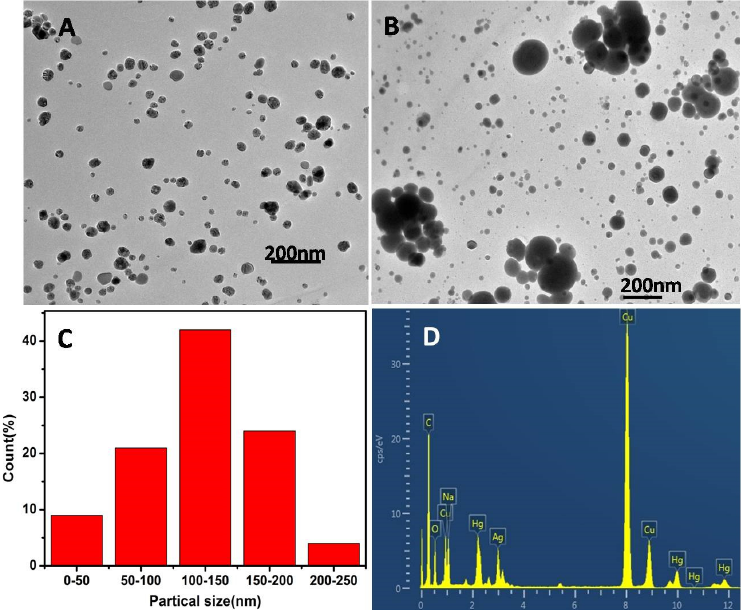
Figure 8. ( A ) TEM of CMS/AgNPs colloidal solution in the presence of Cu 2+ and ( B ) Hg 2+ (30 μ M), ( C ) size distribution, and ( D ) EDS spectrum of CMS/AgNPs with addition of Hg 2+ .